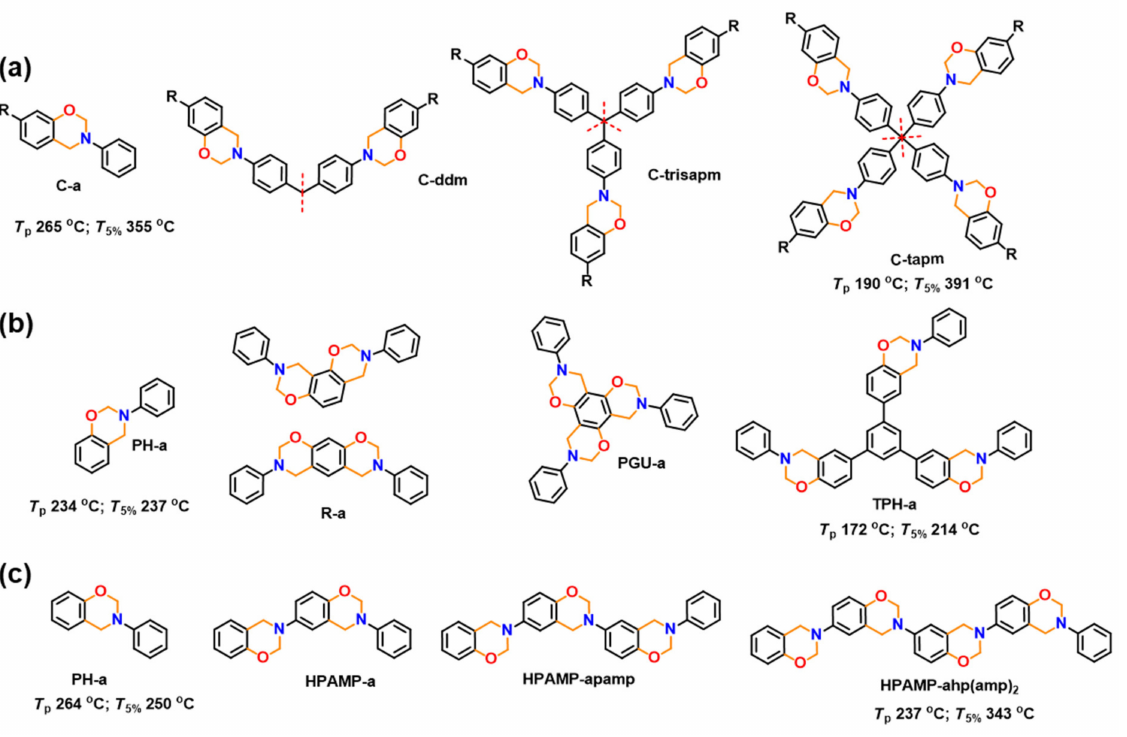
Figure 6. Higher functionality benzoxazine monomers